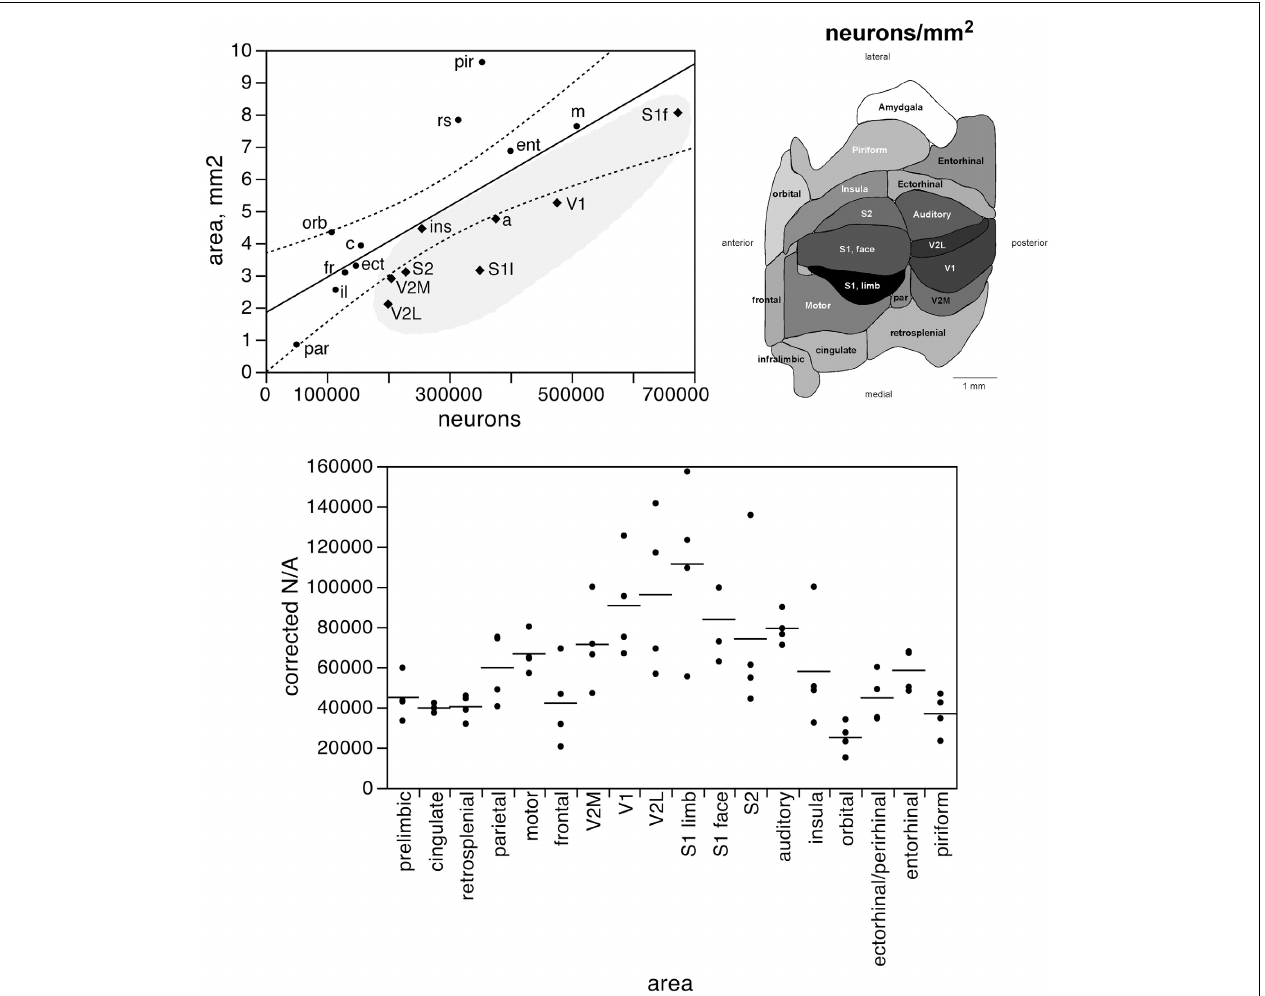
FIGURE 4 | The surface area of each functional area is not tightly correlated to the number of neurons in each area. Top left, surface area of each functional area plotted as a function of the average number of neurons found in that functional area. The fitted line is the linear function that describes the entire dataset, with the 95% confidence interval indicated by the dotted lines. Top right, variation in average surface density